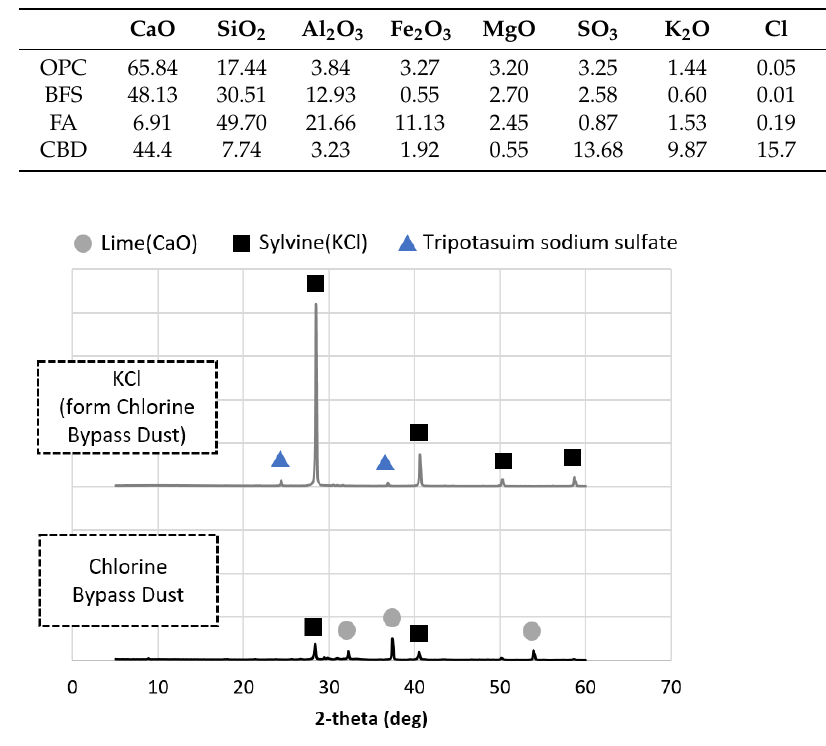
Figure 1. Mineral composition of CBD and KCl.